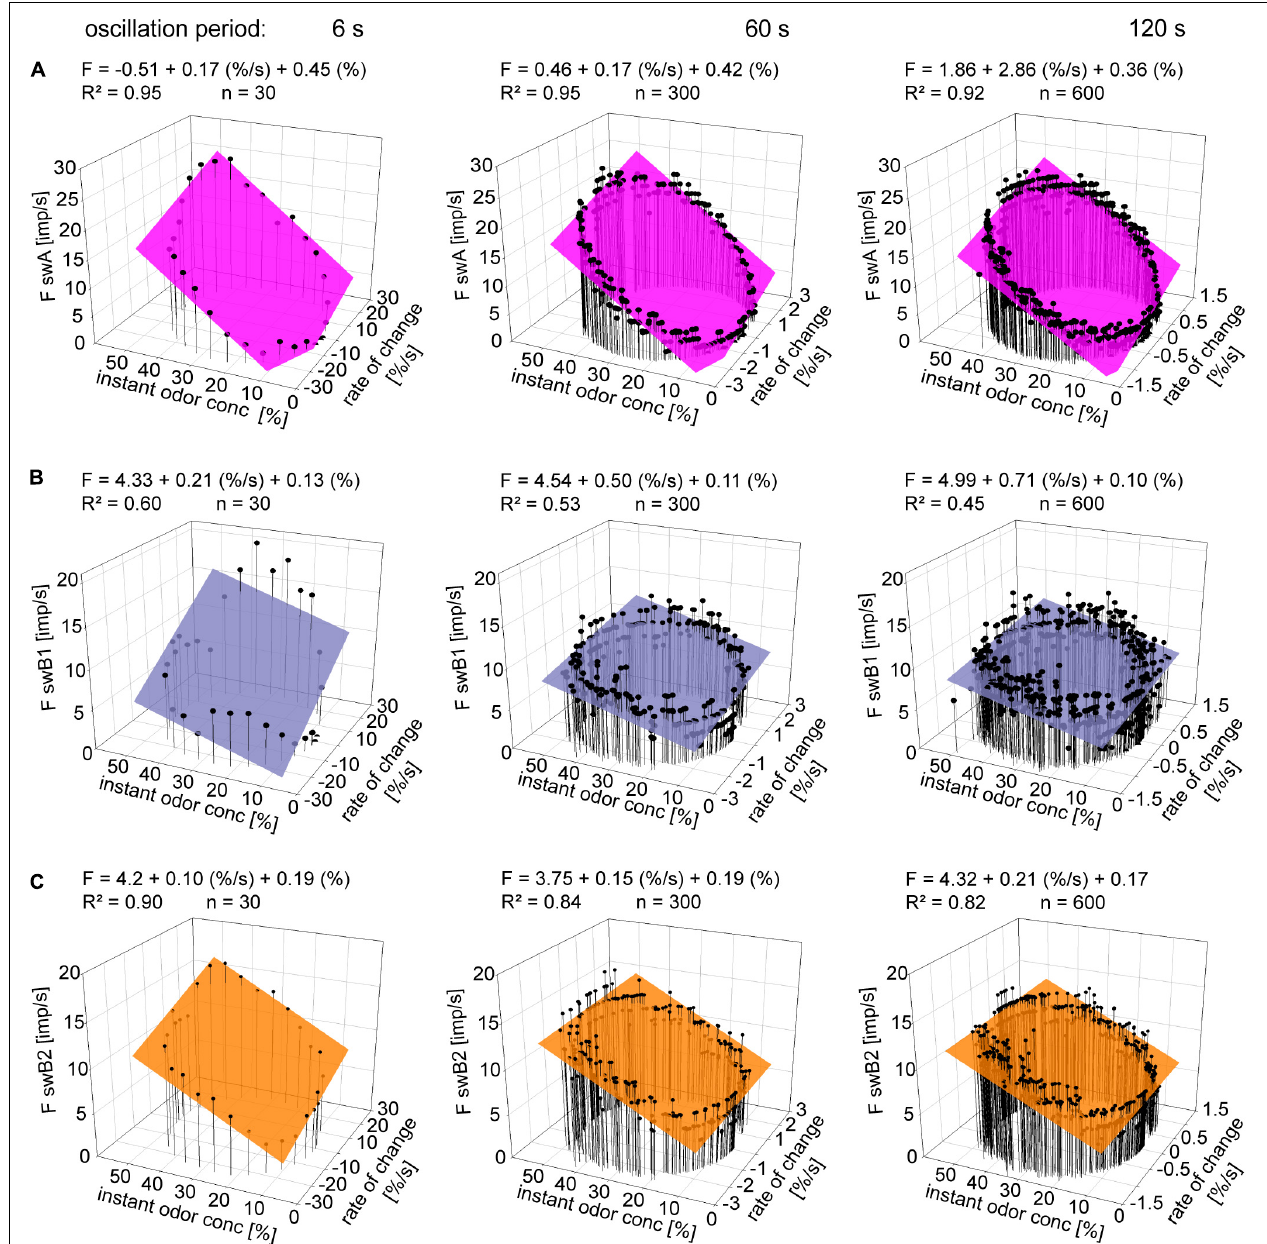
FIGURE 5 | Gain of response for instantaneous concentration and the rate of concentration change. (A–C) Impulse frequencies of a single swA , swB1, and swB2 ORN during three different oscillation periods of odor concentration plotted as a function of instantaneous odor concentration and its rate of change. Multiple regressions which utilize three-dimensional planes [ F = y0 + a dC/dt) + bC] ; where F is the impulse frequency and y0 is the height of the regression plane] were calculated to determine the gain of the responses for instantaneous odor concentration ( b -slope) and the rate of concentration change ( a -slope). R 2 , coefficient of determination; n , number of points per